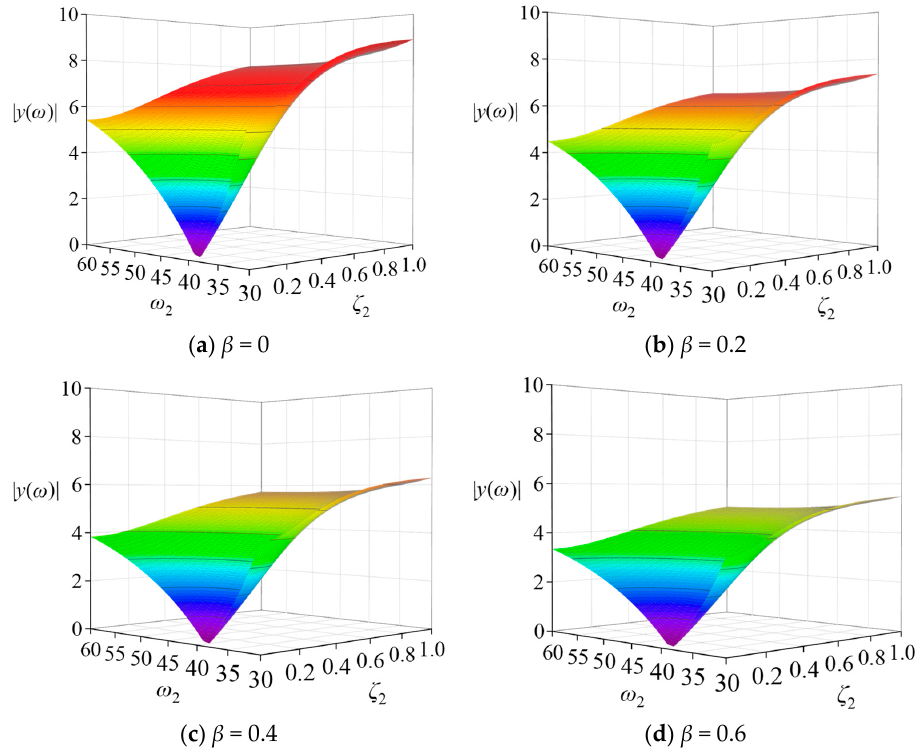
Figure 9. Variation of the maximum displacement in the span, μ = 0.02.